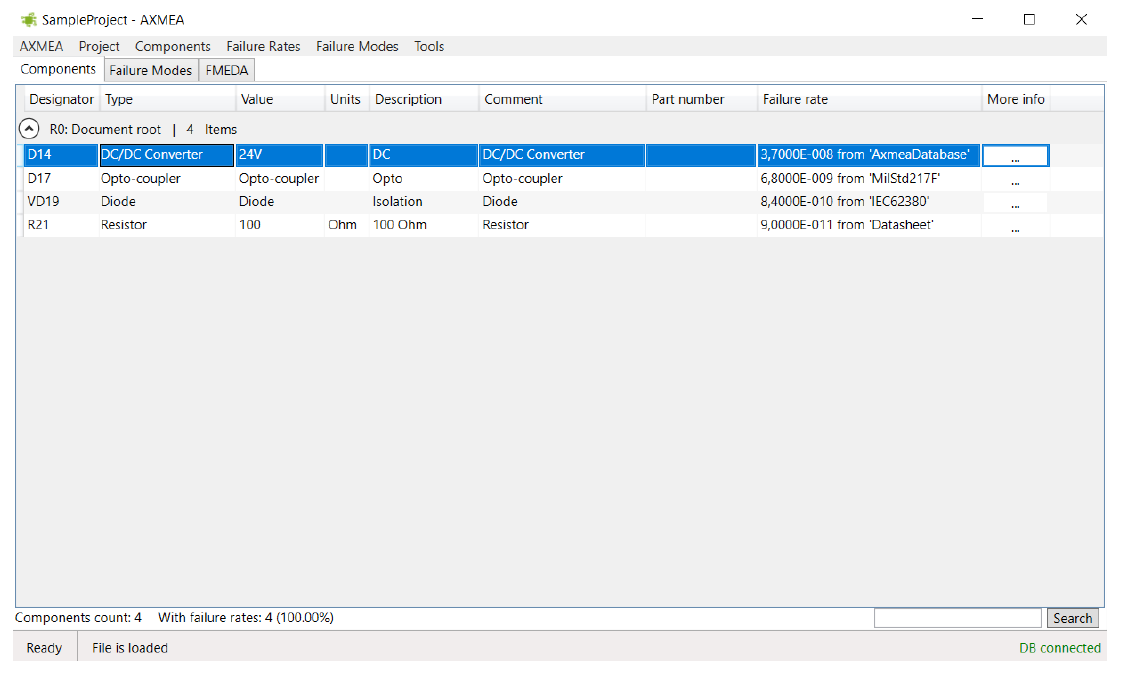
Figure 7. AXMEA tool: automatic failure rate assignment.